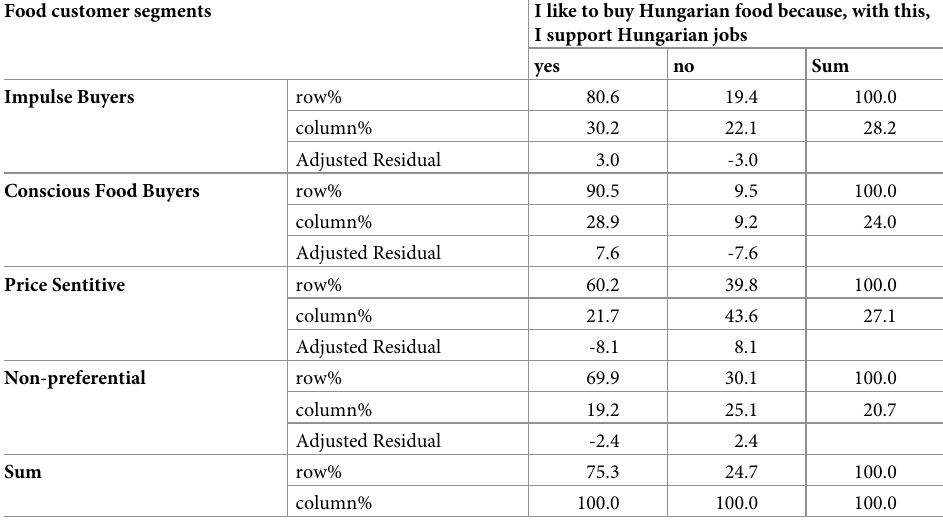
Table 7. Opinions of food purchasing segments on the job-creating ability of Hungarian foods in Hungary. Food customer segments